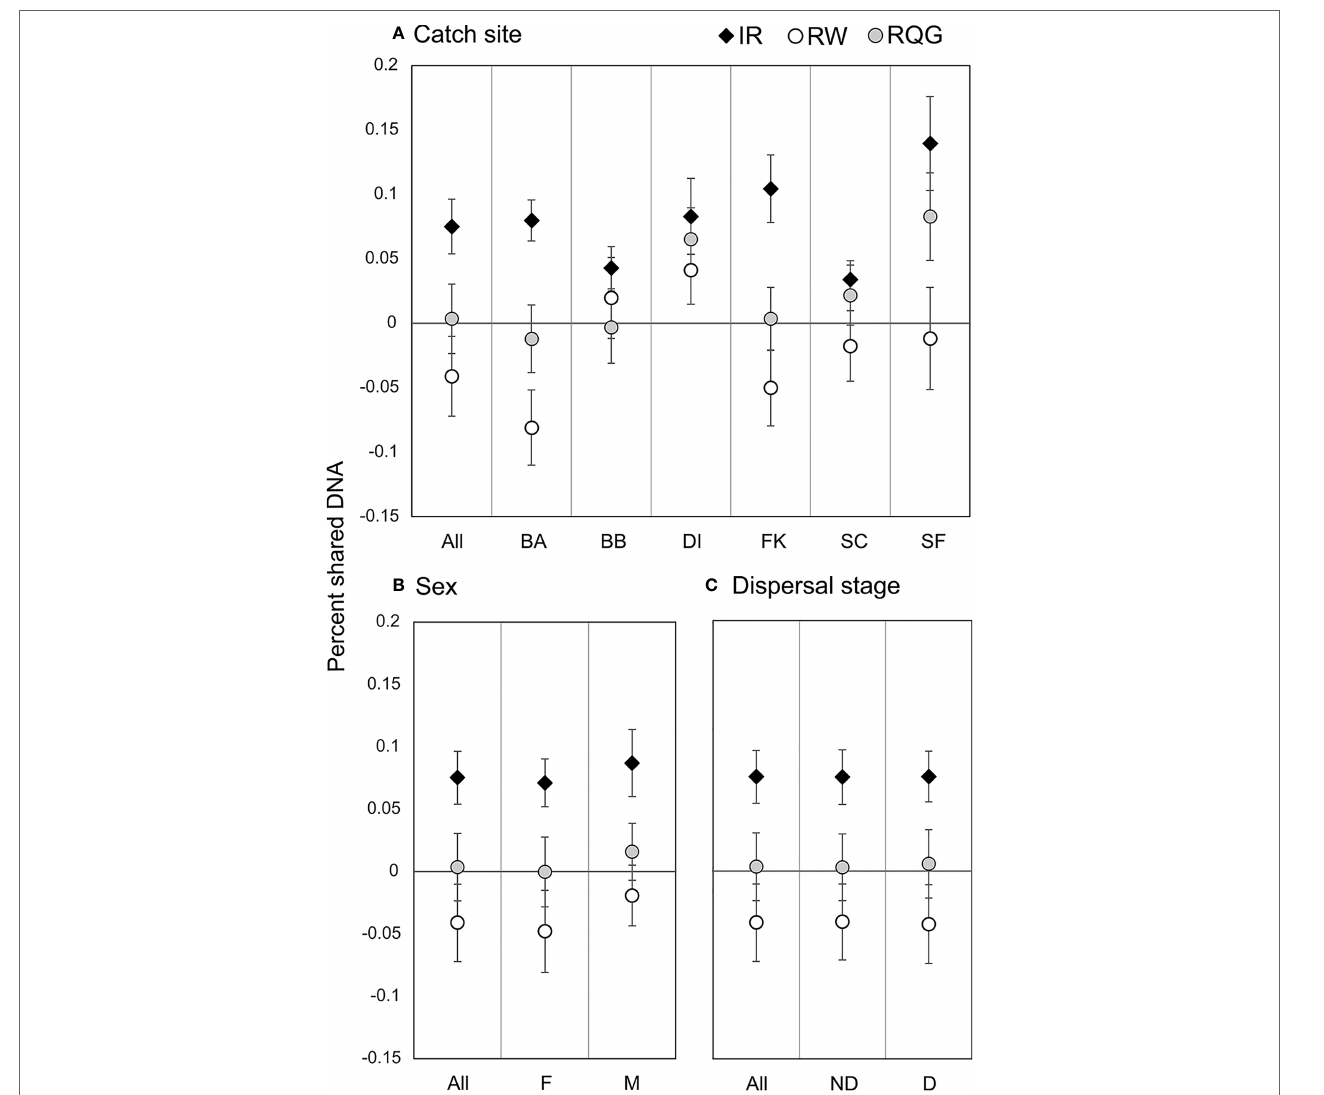
FIGURE 3 | Pairwise relatedness and inbreeding. Circles represent the average pairwise relatedness for the Wang unbiased (R W ) and Queller-Goodnight (R QG ) estimators, and diamonds represent average individual inbreeding coefficient (IR) by (A) catch site (abbreviations from Table 1 ); (B) sex (Male/Female);